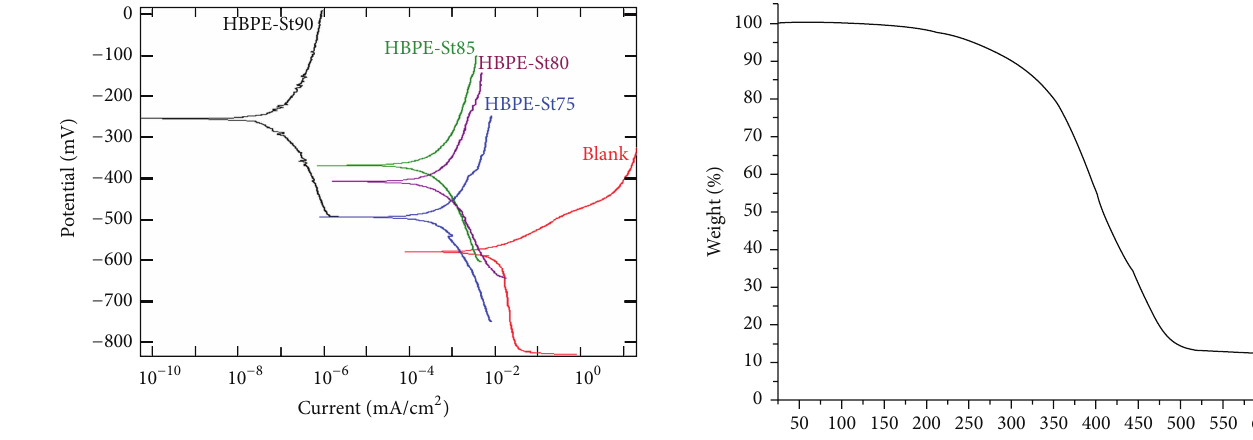
Figure 9: Tafel plots of blank and coated with HBPE-St in 5wt% NaCl solution.